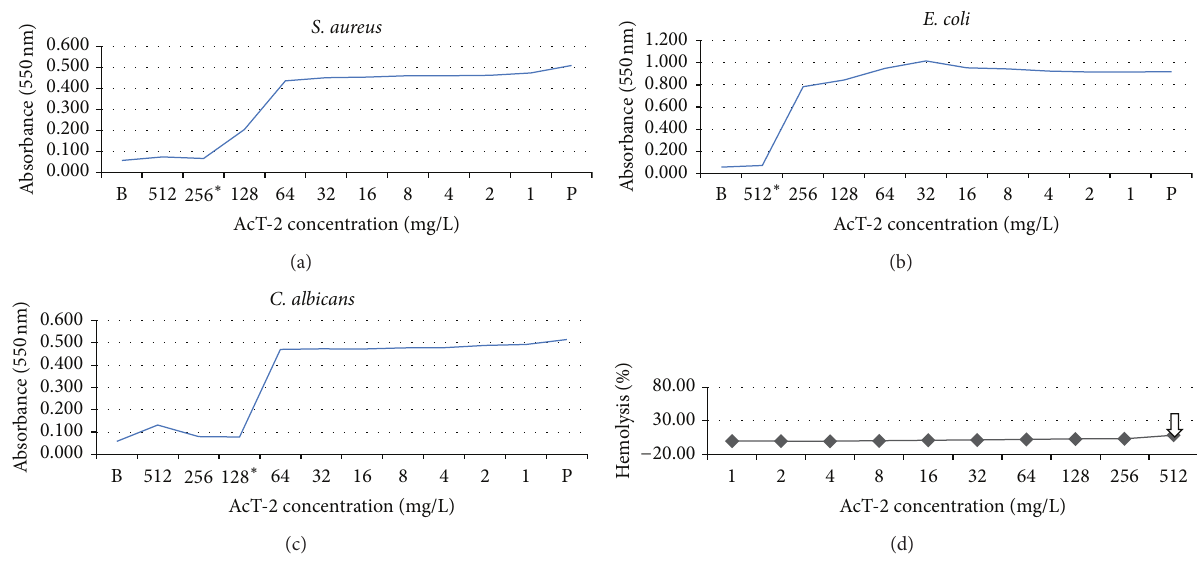
Figure 4: Minimal inhibitory concentration (MIC) curves obtained following incubation of synthetic AcT-2 with S. aureus (a), E. coli (b), and C. albicans (c). The MIC value for each microorganism is indicated in respective panels by asterisks. (d) The hemolytic activity of synthetic AcT-2. The arrow shows the highest concentration of peptide (512mg/L) which was the only concentration at which hemolysis was observed